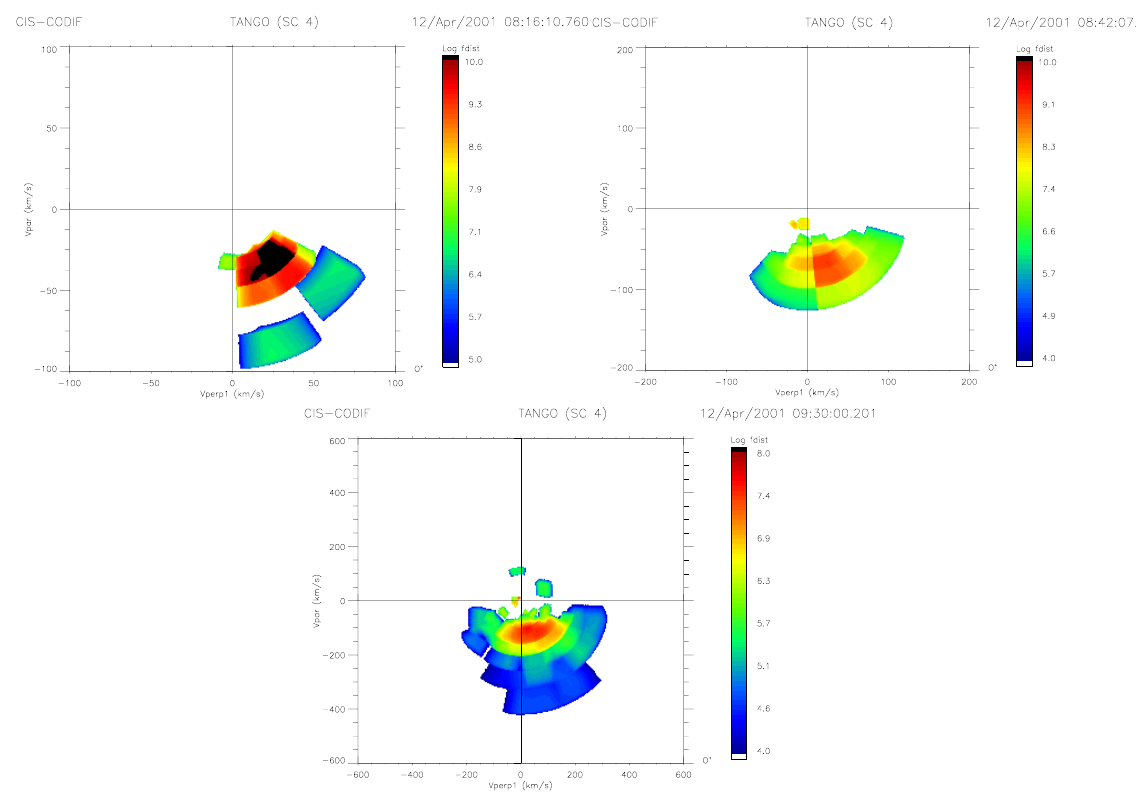
Fig. 2. Sample velocity distributions on 12 April 2001. The figures show V k − V ⊥ distribution and 4-spin (16s) accumulation. The negative sign in the V k axis means upward-going along the field line and the unit of distribution is s 3 /km 6 . From the top-left and clockwise: at 08:16 UT (6.75 R E geocentric distance), 08:42 UT (7.25 R E ), and 09:30 UT (8.13 R E ). As obvious in the figures, the convection velocity of O + ions perpendicular to the magnetic field is calculated about ∼